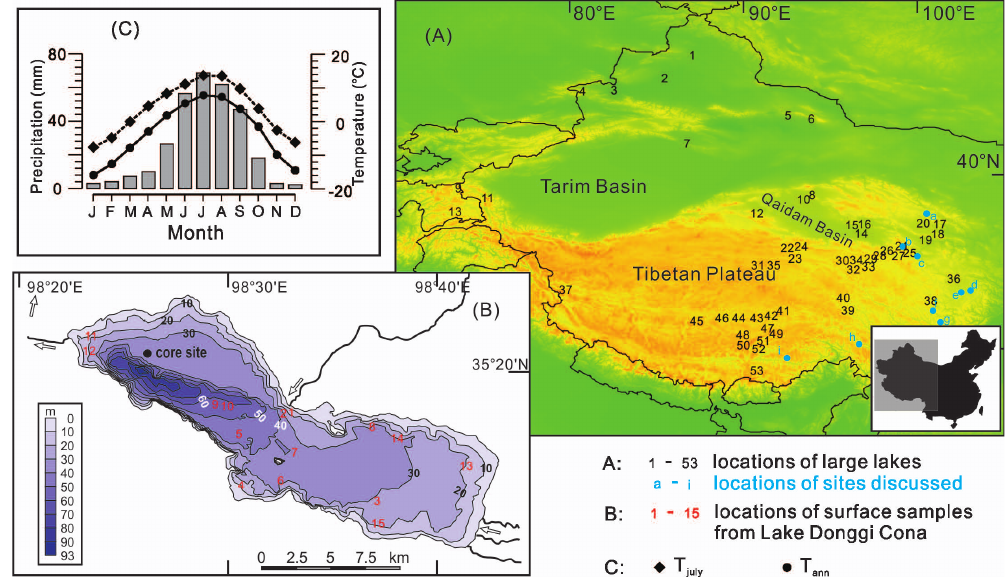
Fig. 1. (A) Overview of the study area and the locations of the large lakes sampled (1–53, see detailed information in Table 1), as well as study sites mentioned in the text: a, Lake Luanhaizi; b, Lake Donggi Cona; c, Kuhai Lake; d, no. 2 pit; e, Lake Ximen Co; f, Naleng Lake; g, Yidun Lake; h, Ren Co; i, Hidden Lake. (B) Bathymetric map of Lake Donggi Cona showing the surface sediment sample locations (1–15) and the core site (PG1790), with arrows indicating the major inflows and outflows. (C) Meteorological data between 1950 and 1990AD, from the Madoi station: mean annual precipitation ( P ann , bars), mean annual temperature ( T ann , points) and mean July temperature ( T July ,